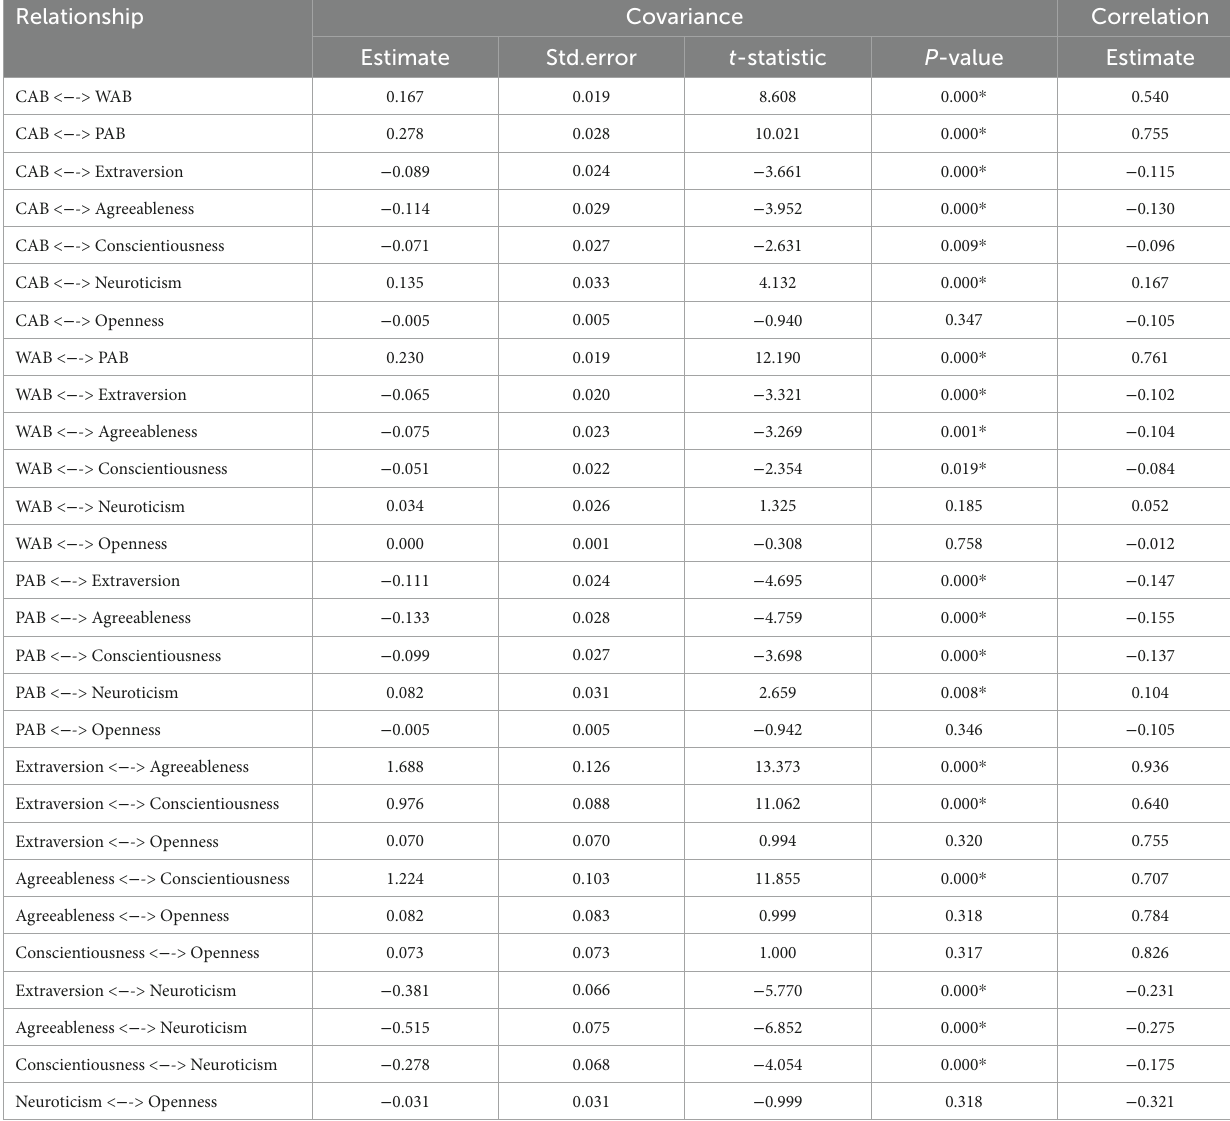
TABLE 5 Links between the latent variables of the combined model of BOSSm18 and